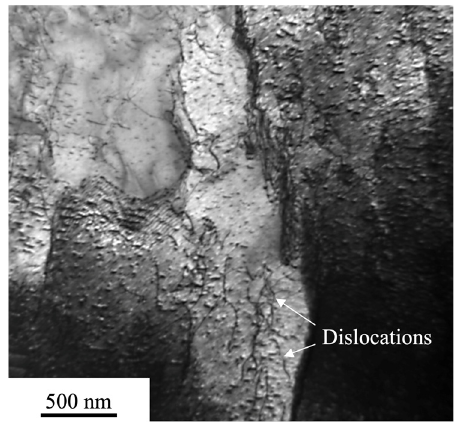
Figure 6. TEM image of dislocations’ distribution in the transition